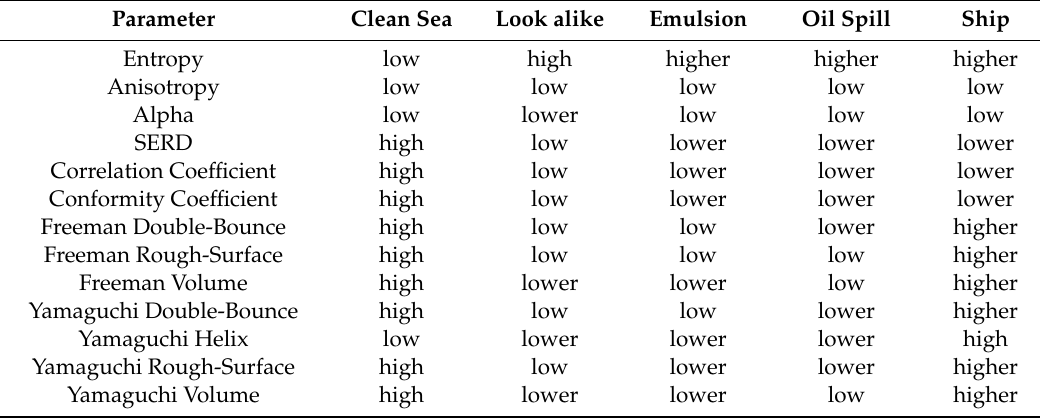
Table 3. Characteristics of polarized parameters in experiments.